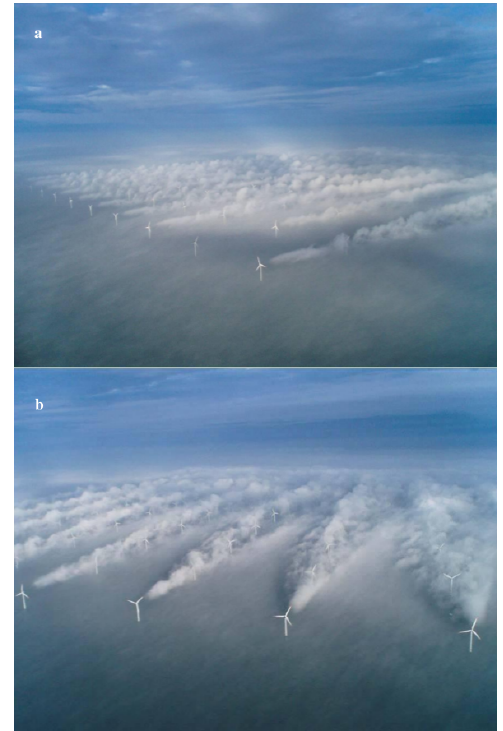
Figure 3: Wake e(cid:27)ects (photograph of the Horns Rev 1 o(cid:27)shore wind farm, Hasager et al. (2013)).